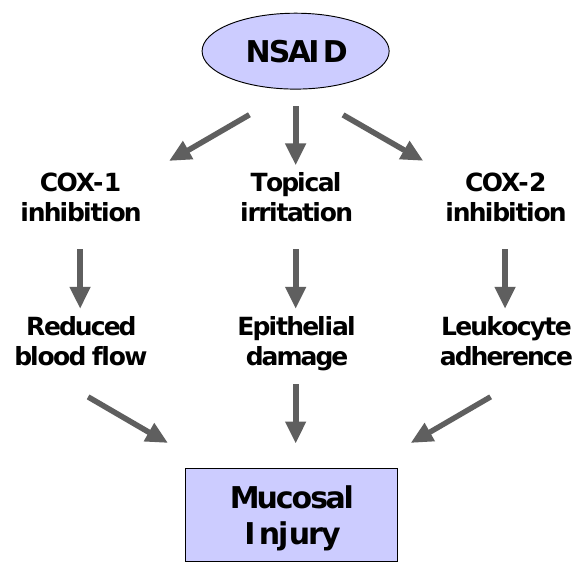
FIGURE 3. Pathogenesis of NSAID-induced gastric damage. Inhibition of COX-1 and COX-2, as well as topical irritant properties of NSAIDs, each contribute to the elicitation of gastric